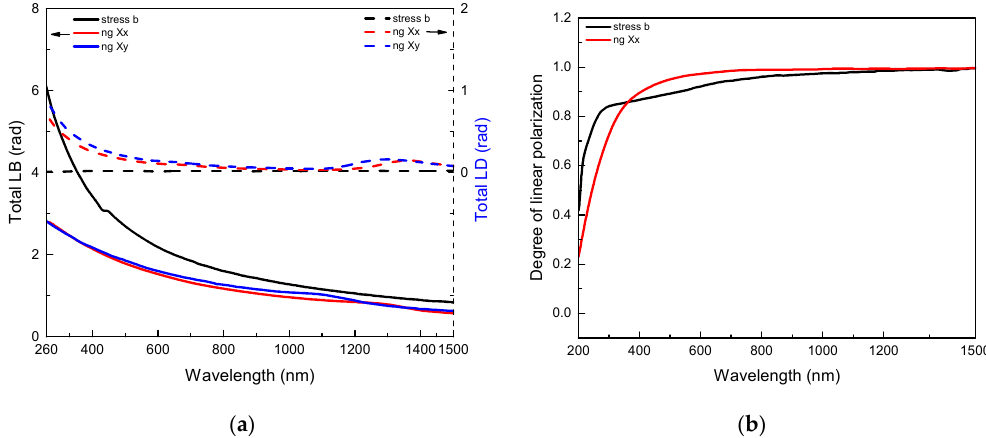
Figure 3. ( a ) Spectral dependence of the anisotropic linear optical properties Total LB (continuous lines) and Total LD (dashed lines) extracted from Mueller matrix decomposition. Black lines are for the stress-engineered waveplate (a half waveplate at 450 nm) whereas red and blue lines are for nanogratings-based waveplates written in Xx and Xy configurations. ( b ) Spectral dependence of the linear Degree of Polarization.